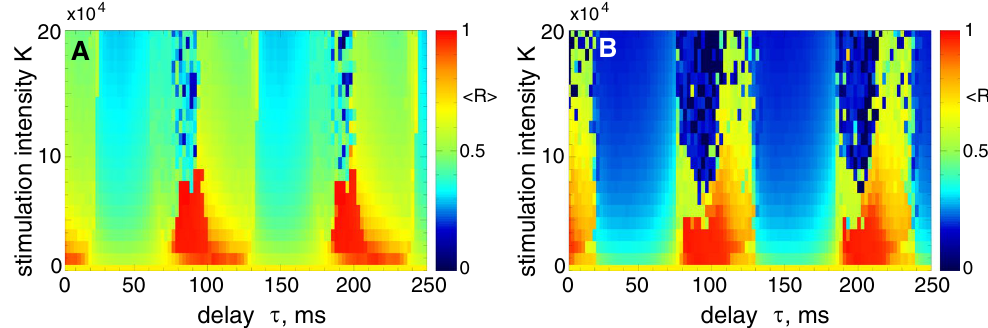
Figure 7. Impact of the pulsatile NDF stimulation (7) on the neuronal ensemble (1)-(3). The time-averaged order parameter 〈 R ( t ) 〉 of the stimulated STN neurons is depicted in color ranging from 0 (blue) to 1 (red) versus feedback delay τ and stimulation intensity K for the interphase gap width ( A ) GW = 0 ms and ( B ) GW = 5 ms.